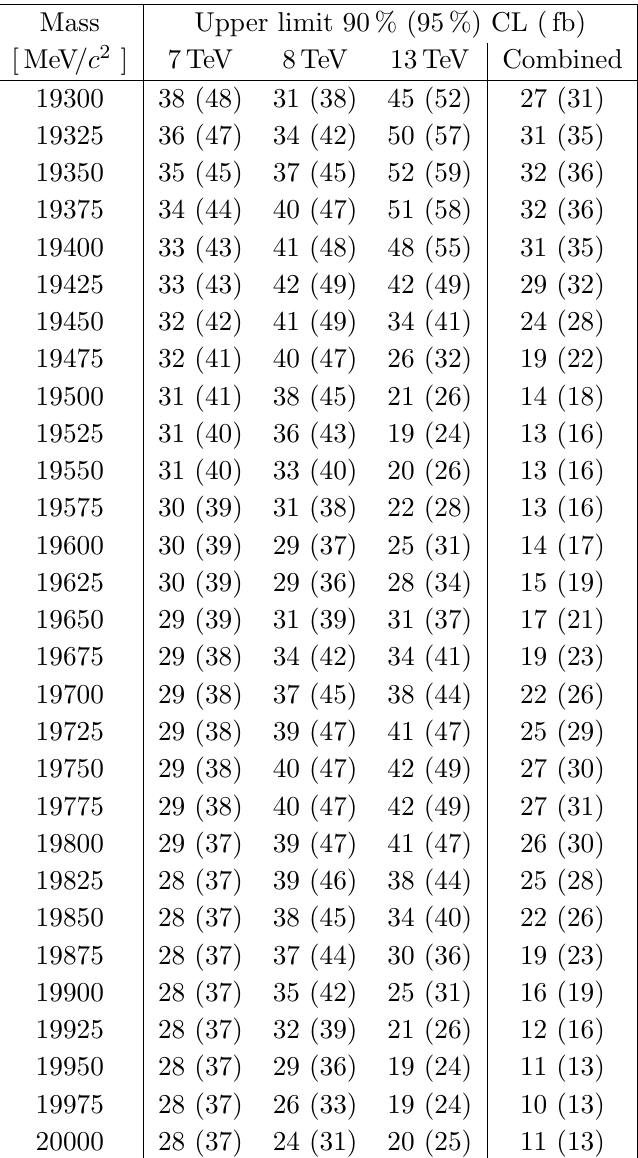
Table 3 . Upper limits on (cid:27) ( pp ! X ) (cid:2) B ( X ! (cid:7) (1 S ) (cid:22) + (cid:22) (cid:0) ) (cid:2) B ( (cid:7) (1 S ) ! (cid:22) + (cid:22) (cid:0) ) for di(cid:11)erent X mass hypotheses in the range [19 : 3 ; 20 : 0] GeV =c 2